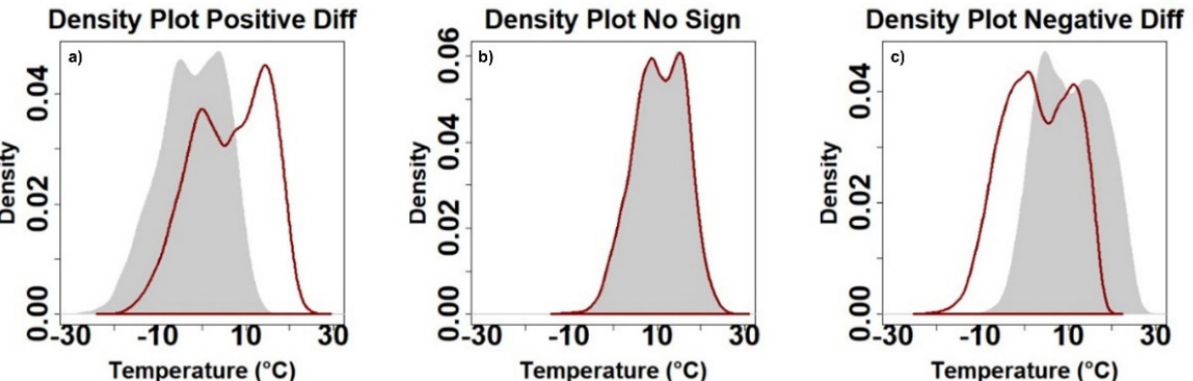
Figure 7. Density plot for temperature of ( a ) the highest positive difference, ( b ) no difference and ( c ) the highest negative difference between stations and ERA5. The grey area refers to the stations’ data and the red line refers to the corresponding ERA5 data.